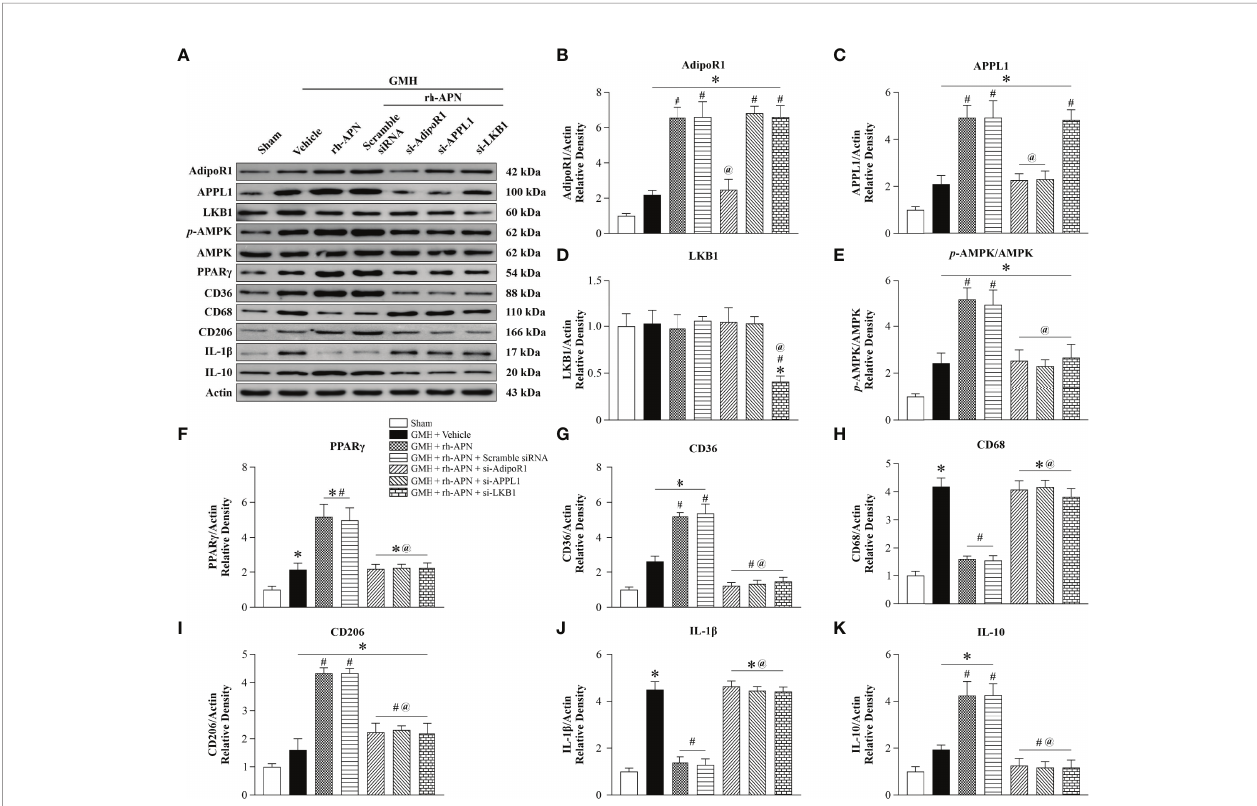
FIGURE 7 | AdipoR1/APPL1/LKB1/AMPK signaling is a potential pathway for rh-APN afforded anti-in fl ammation in GMH pups. (A) Representative images of Western blot data showing the expression of AdipoR1, APPL1, LKB1, p-AMPK, PPAR g , CD36, CD68, CD206, IL-1 b , and IL-10 either with rh-APN treatment alone, rh-APN + si-AdipoR1, rh-APN + si-APPL1, or rh-APN + si-LKB1. (B) Western blot analysis of AdipoR1 showed that AdipoR1 levels increased in rh-APN treatment group and decreased in the si-AdipoR1 group, while AdipoR1 expression does not change in si-APPL1 or si-LKB1 pups with rh-APN treatment. (C) Western blot analysis of APPL1 showed that APPL1 expression was increased in the rh-APN-treated group and decreased in si-AdipoR1 and si-APPL1 groups. However, there were no signi fi cant changes of APPL1 levels after knockdown of LKB1 with si-LKB1. (D) Western blot analysis of LKB1 showed that LKB1 levels decreased in si- LKB1 treated group. (E) Western blot analysis of p-AMPK to AMPK ratio showed that p-AMPK increased in the rh-APN-treated group and decreased in si-AdipoR1, si-APPL1, and si-LKB1 groups. (F, G, I, K) Western blot data showed that (F) PPAR g , (G) CD36, (I) CD206, and (K) IL-10 expression increased in rh-APN treated group and decreased in si-AdipoR1, si-APPL1, and si-LKB1 groups. (H, J) Western blot data showed that (H) CD68 and (J) IL-1 b expression were signi fi cantly decreased with rh-APN treatment while si-AdipoR1, si-APPL1, and si-LKB1 reversed the inhibitory effects of rh-APN. Values are expressed as mean ± SD. ANOVA, Dunnett. n = 6 for each group. * P < 0.05 compared to sham, # P < 0.05 compared to GMH + Vehicle, @ P < 0.05 compared to GMH + rh-APN or GMH + rh-APN + Scramble